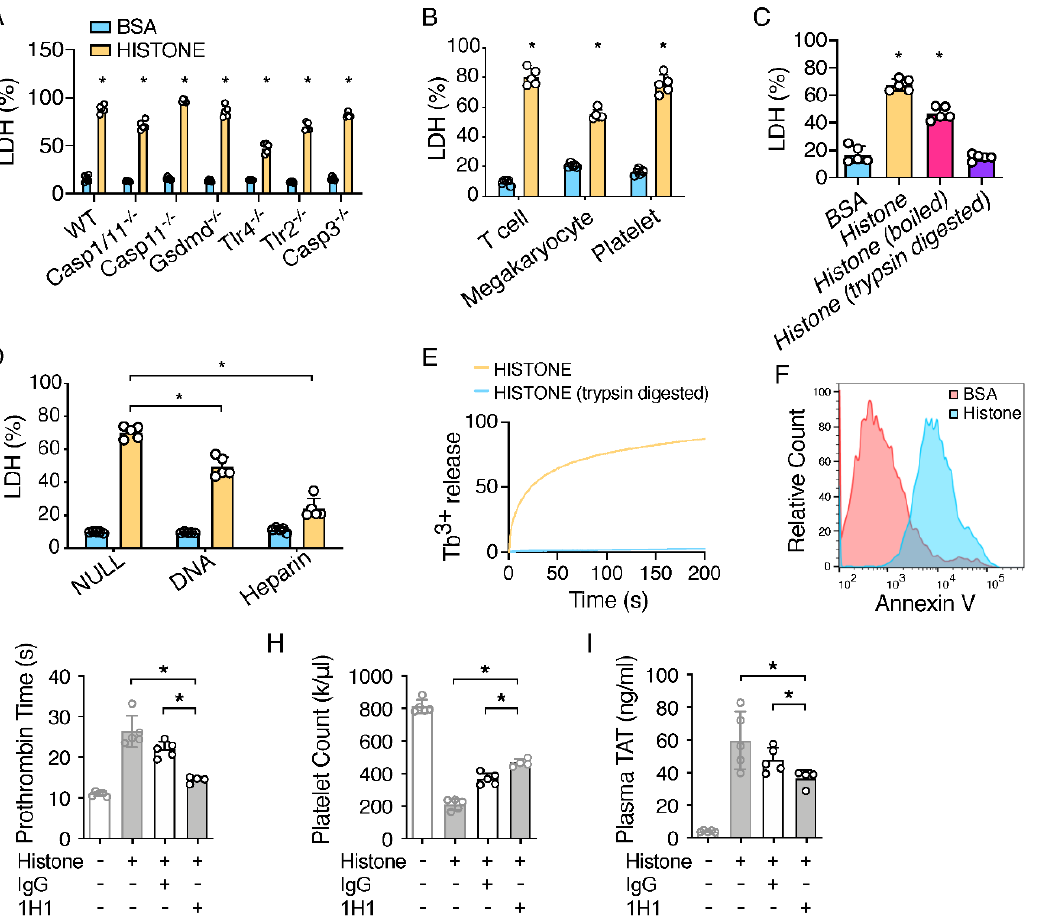
Figure 2. ( A – F ) Extracellular histones induced lytic cell death and PS exposure. ( A ) Histones lysed macrophages. BMDMs were isolated from C57BL/6J mice (WT), Casp1/11-deficient mice, Casp11- deficient mice, GSDMD-deficient mice, TLR4-deficient mice, TLR2-deficient mice, and Casp3-defi- cient mice. Cells were incubated with BSA or histones for 60 min. ( B ) Extracellular histones lysed many other cell types. T cells, megakaryocytes, and platelets were incubated with BSA or histone for 60 min. ( C ) Histones, even when subjected to boiling, lysed macrophages. Histones, boiled his- tones, and trypsin-digested histones (500 µg/mL) were incubated with BMDM for 60 min. Error bars denote SD; * p < 0.05 versus BSA, Mann – Whitney test. ( D ) Both DNA and heparin blocked histone-